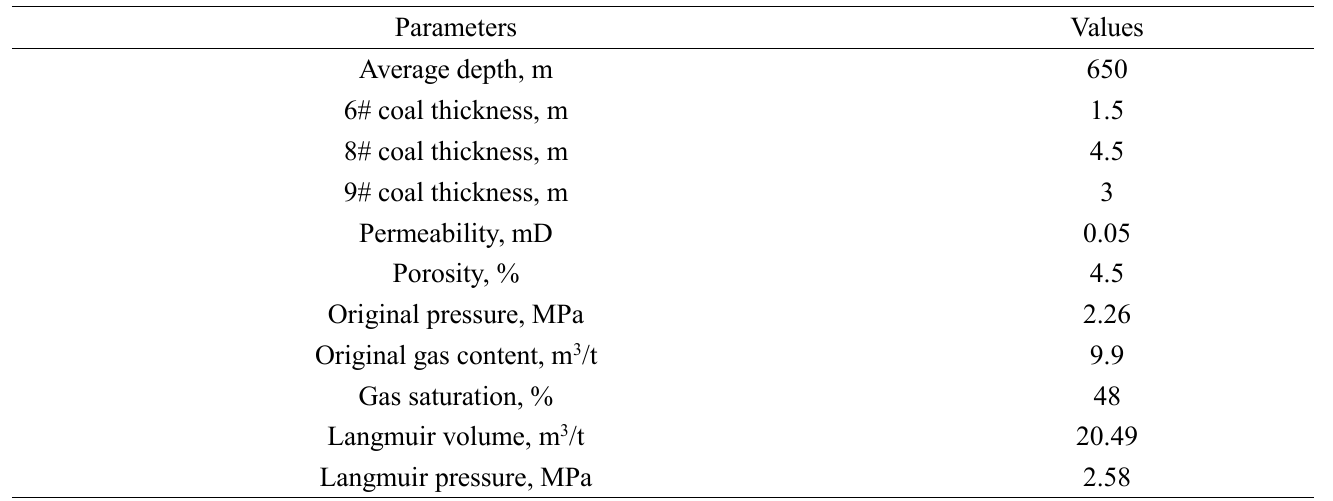
Table 3—The basic parameters of the